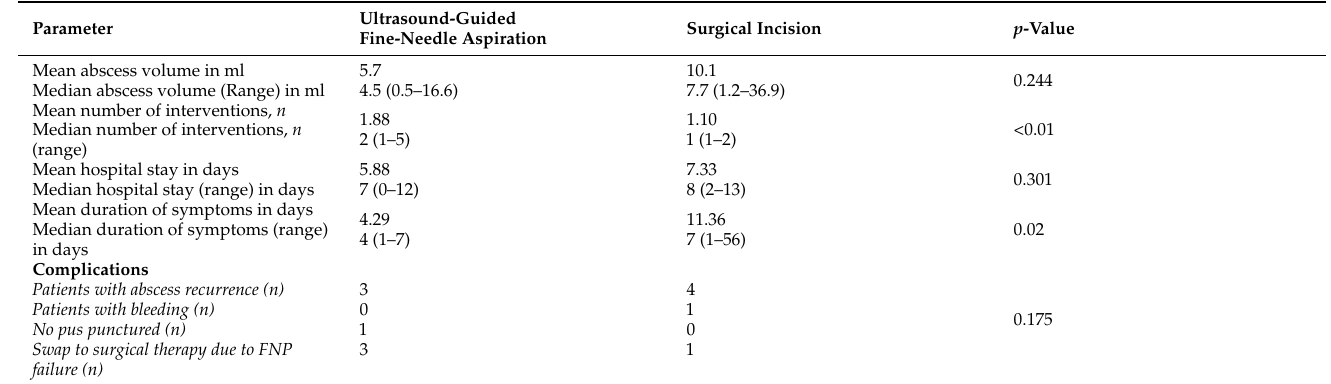
Table 3. Treatment outcomes: differences between ultrasound-guided needle aspiration and surgical incision.